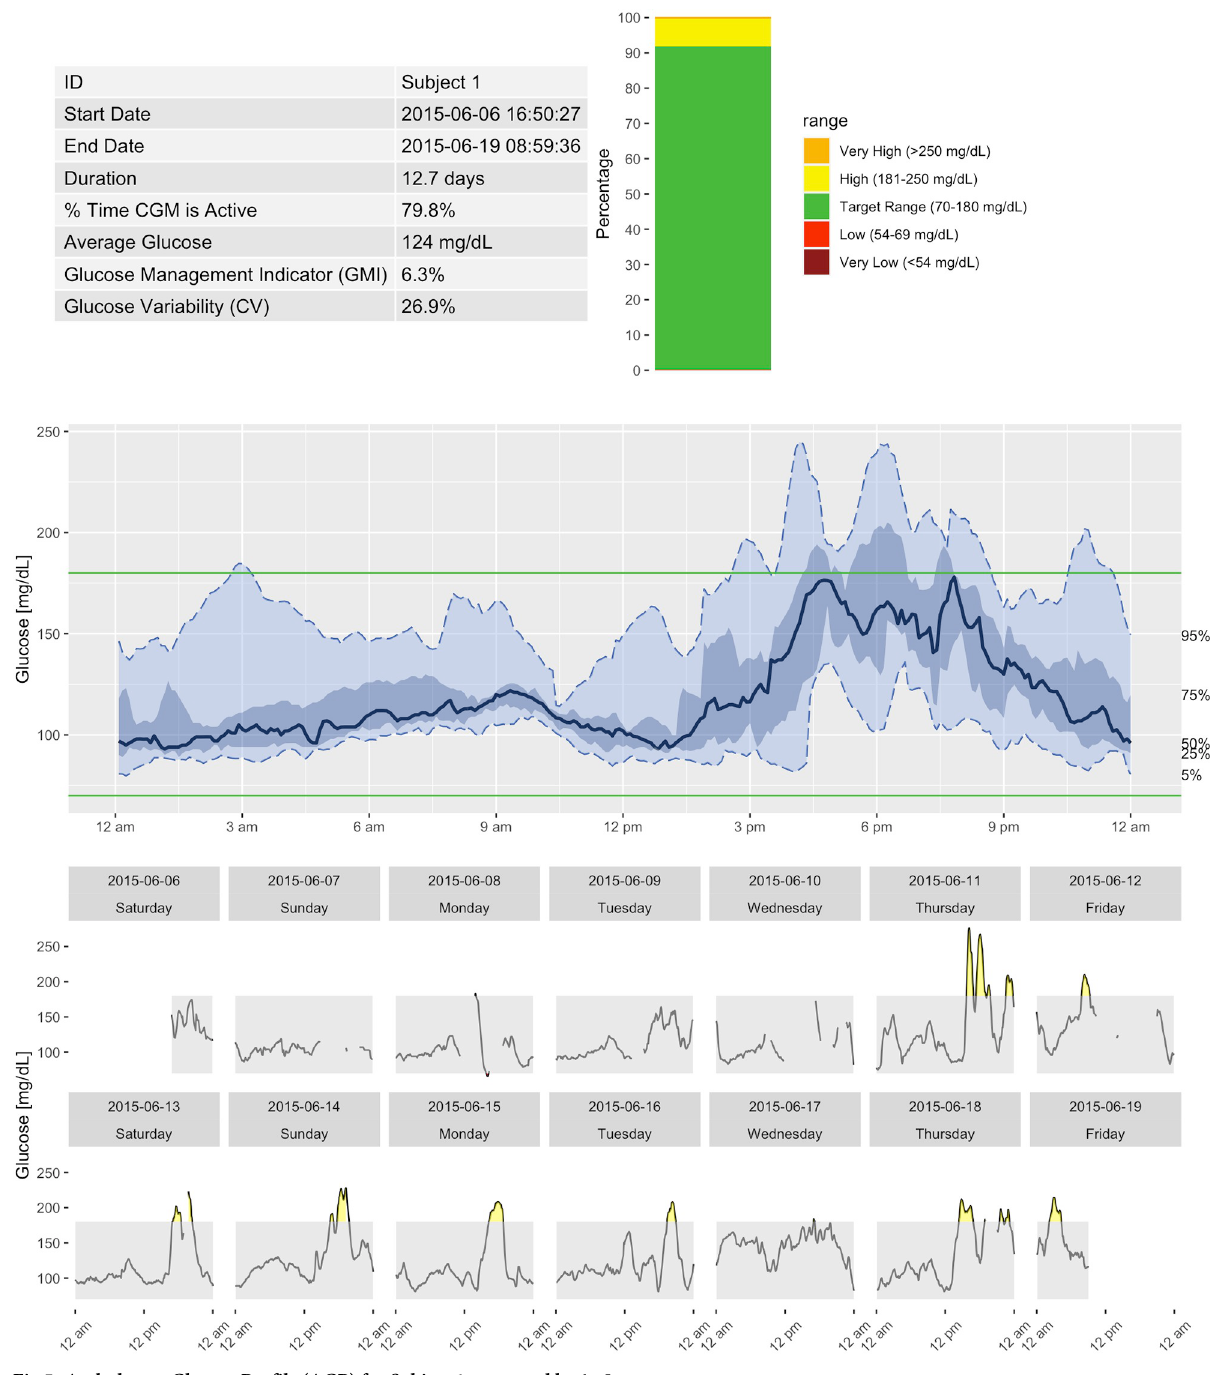
Fig 5. Ambulatory Glucose Profile (AGP) for Subject 1 generated by iglu